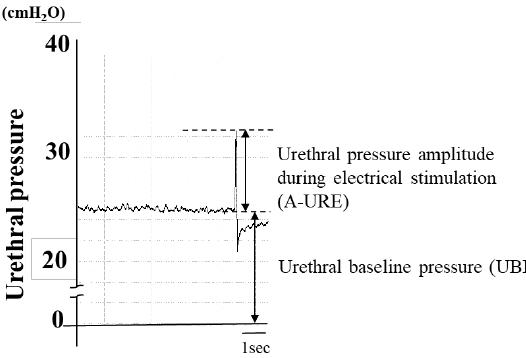
Figure 2. Urethral pressure amplitude during electrical stimulation (A-URE) and urethral baseline pressure (UBP). The urethral baseline pressure (UBP) was defined as the flat section of the pressure recording that is seen just before the response to the electrical stimulation. The amplitude during the electrical stimulation (A-URE) was defined as the average value of the maximal urethral pressure change from the UBP when electrical stimulations were given to cause pressure changes from the UBP [19].